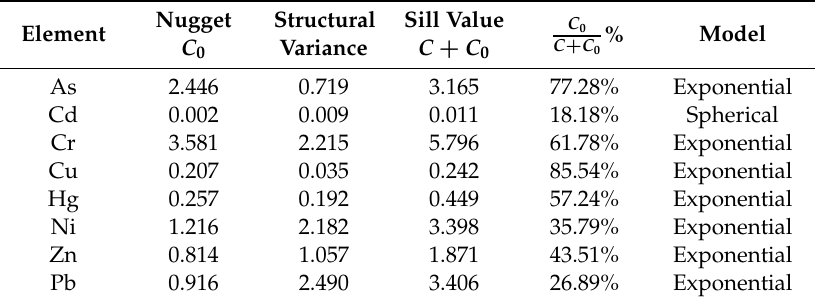
Table 1. Semivariance parameter of the heavy metals.